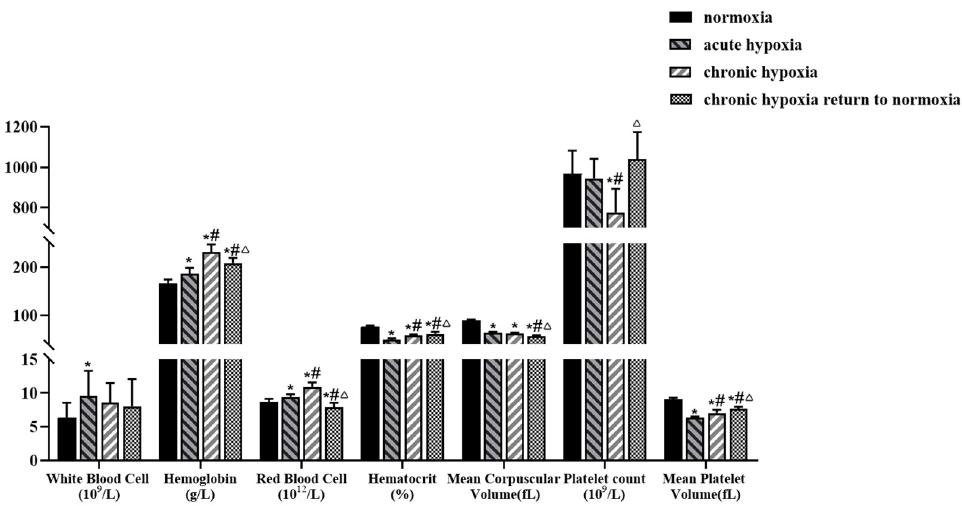
Figure 1. Changes in white blood cell, hemoglobin, red blood cell, hematocrit, mean corpuscular volume, platelet count, and mean platelet volume in rats after exposure to high-altitude hypoxia. The data are presented as mean ± SD. n = 8. * p < 0.05 compared to the normoxia group; # p < 0.05 compared to the acute hypoxia group; ∆ p < 0.05 compared to the chronic hypoxia